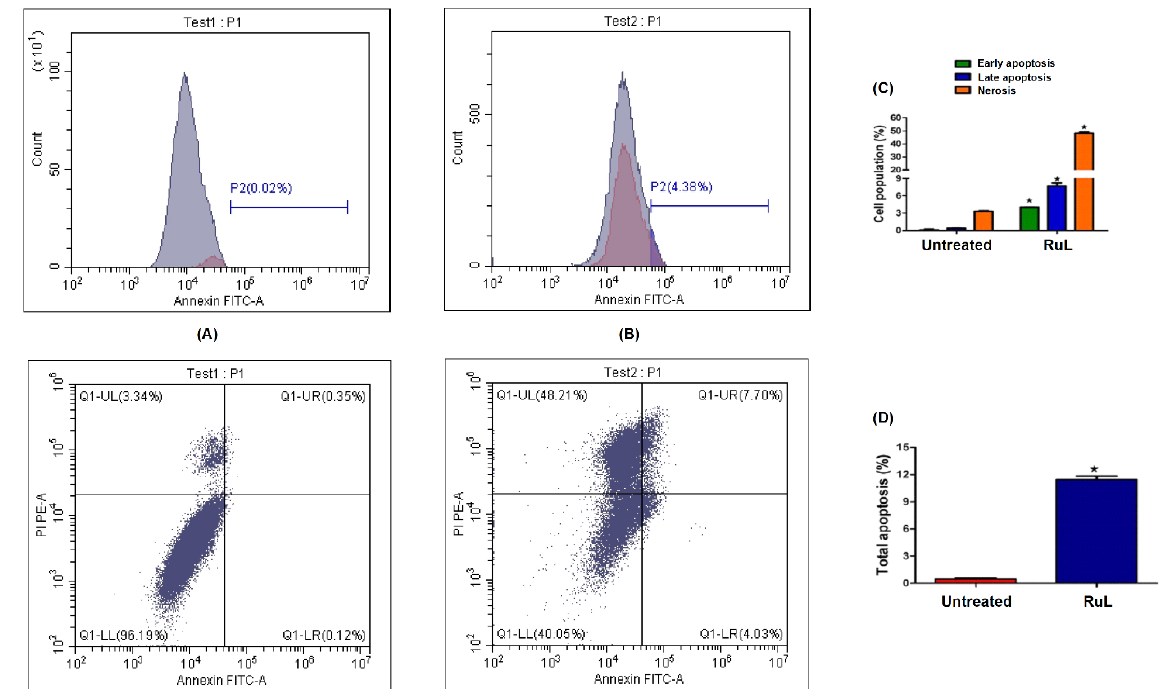
Figure 5. Effect of RuL on the cell death of HepG2 cells by flow cytometry using annexin V-FITC/PI staining: ( A ) untreated HepG2 cells (control), ( B ) RuL -treated HepG2 cells, ( C ) the effect of RuL on cell apoptosis in HepG2 cells. ( D ) Cell population against apoptosis phases. Data are given as mean ± SD performed in triplicate. Statistical differences were analyzed with a t -test. * Significant at p < 0.05.